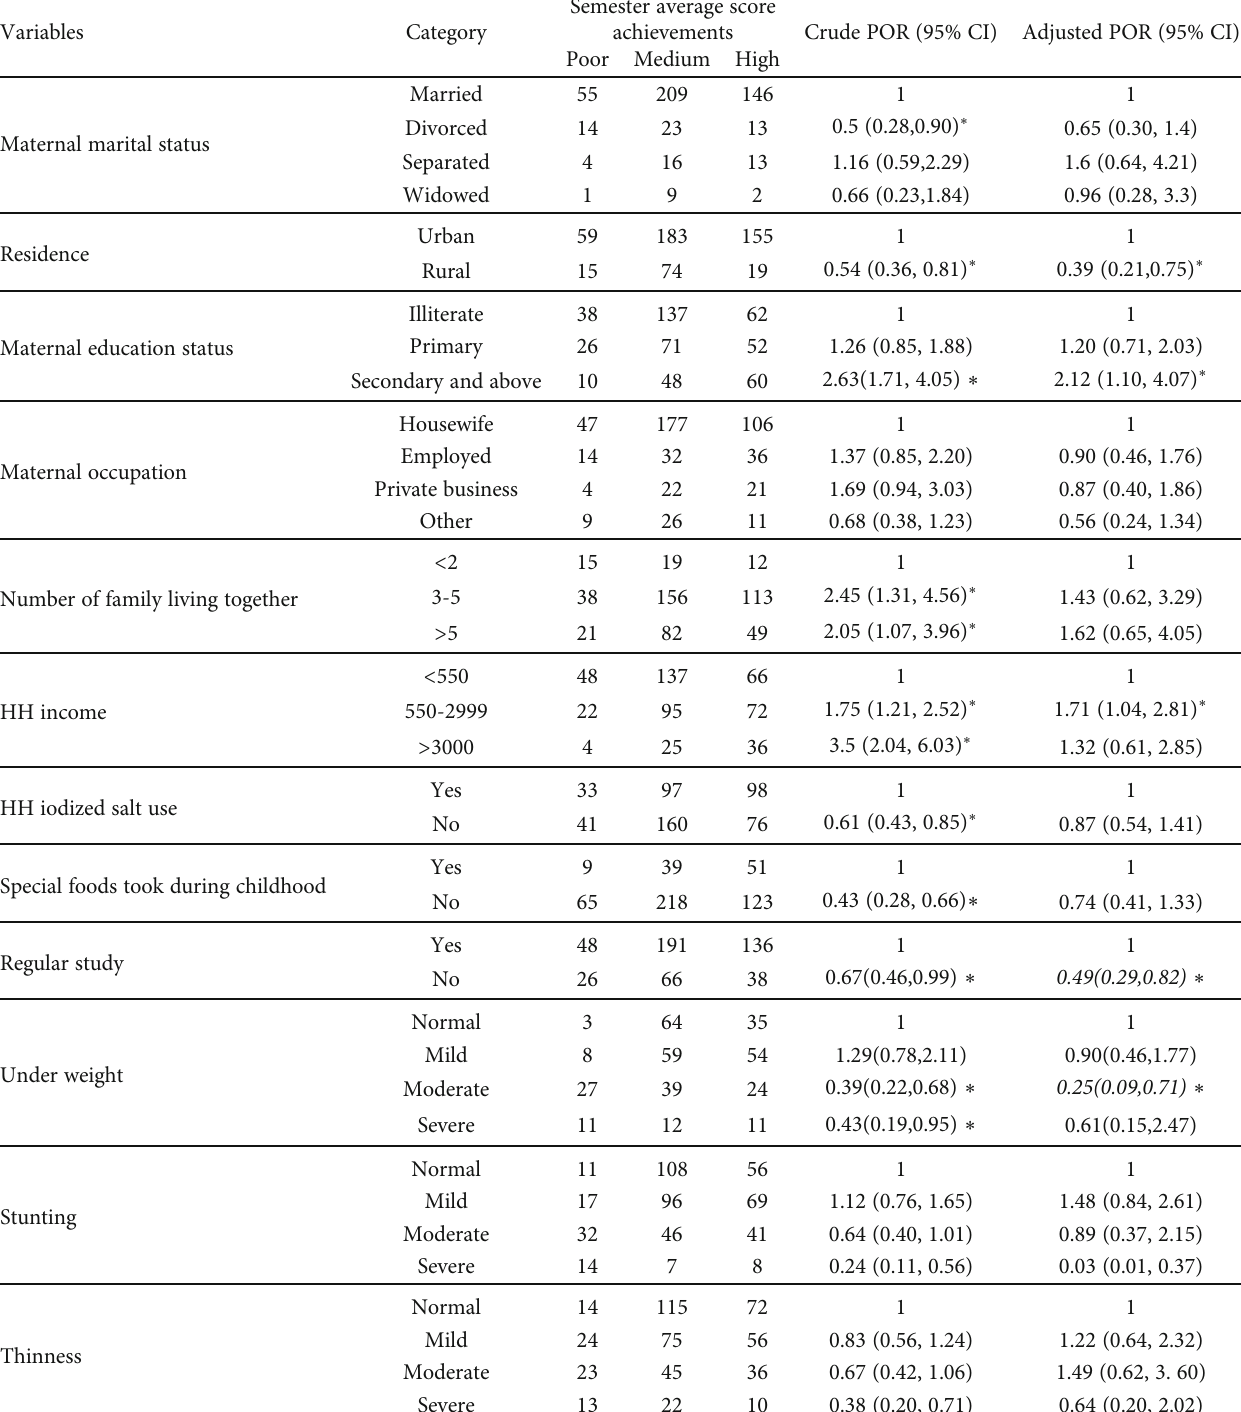
Table 3: Factors associated with average semester score achievement among school-aged children in Lalibela town, North